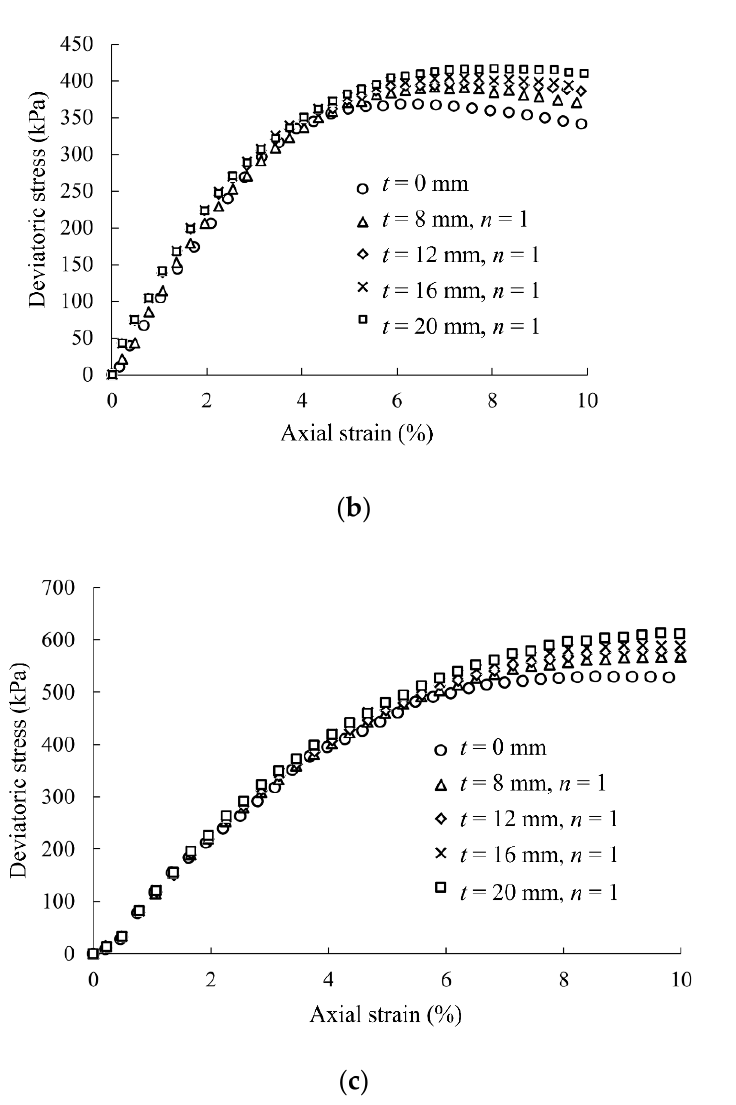
Figure 10. The deviatoric stress–axial strain curves of the LGSCR samples at different thicknesses of sand layers and confining pressures of ( a ) 150 kPa, ( b ) 250 kPa, and ( c ) 400 kPa.